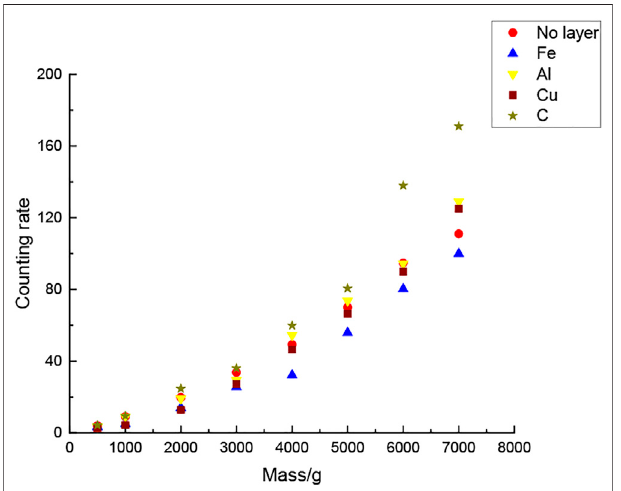
FIGURE 10 | Double counting rate of different packaging materials.